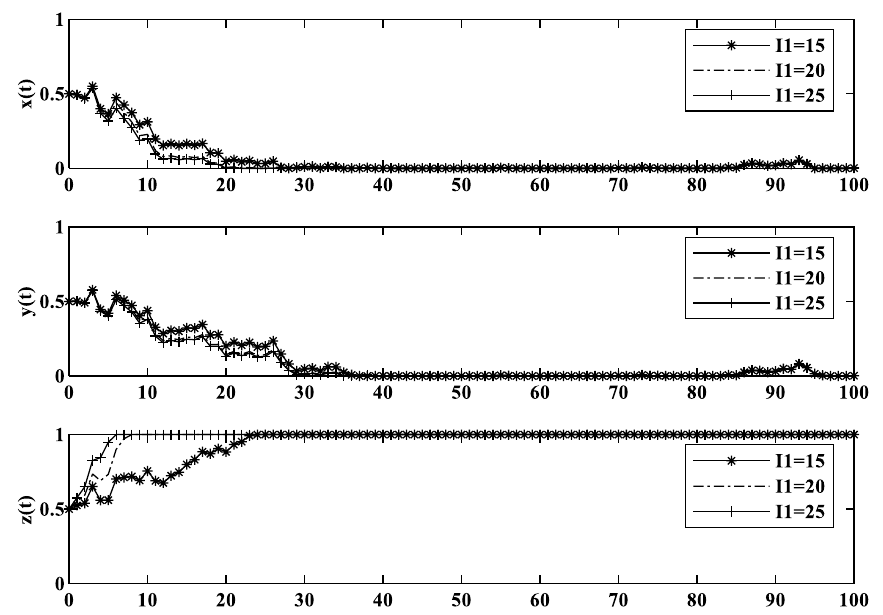
Fig. 5 Impact of supervise incentives on evolutionary process under scenario